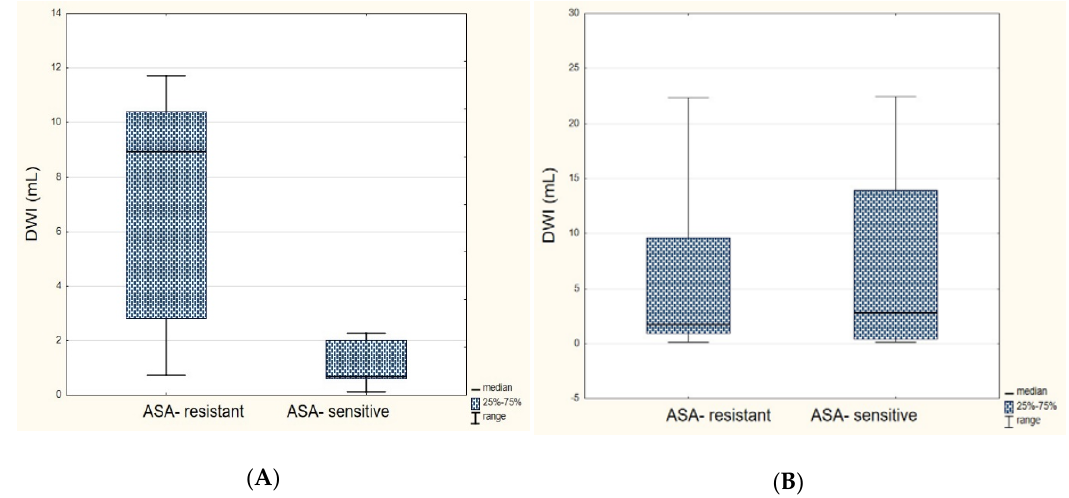
Figure 4. Comparison of ischemic focus size (in mL) in the diffusion ‐ weighted imaging (DWI) sequence in the group of patients resistant and sensitive to Aspirin (ASA) in the large artery atherosclerosis subgroup ( A ) and the small ‐ vessel disease subgroup ( B ).